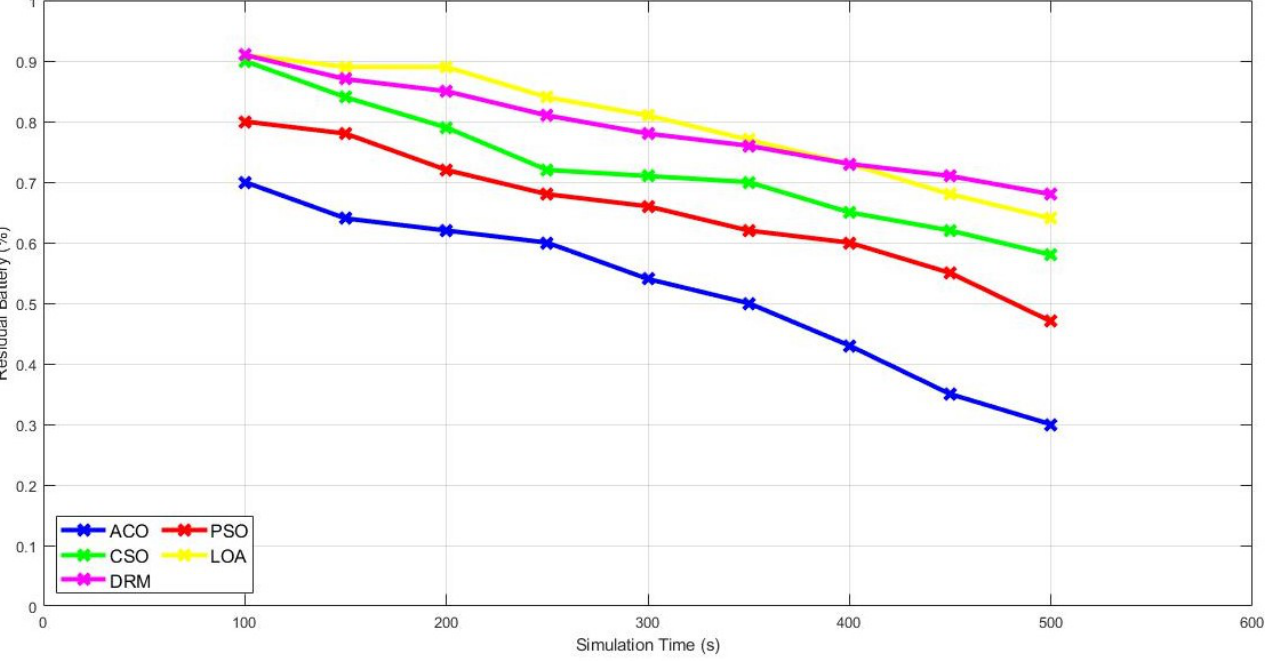
Figure 8. Average energy consumption